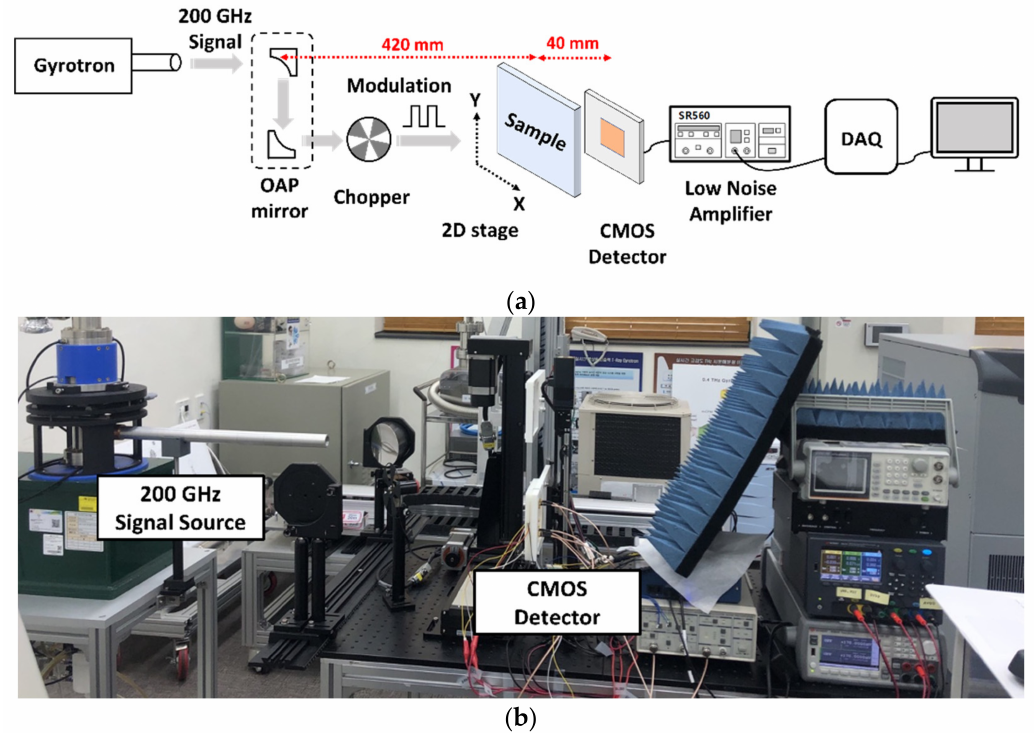
Figure 9. Measurement setup: ( a ) block diagram for THz imaging using raster scanning; ( b ) experi- mental